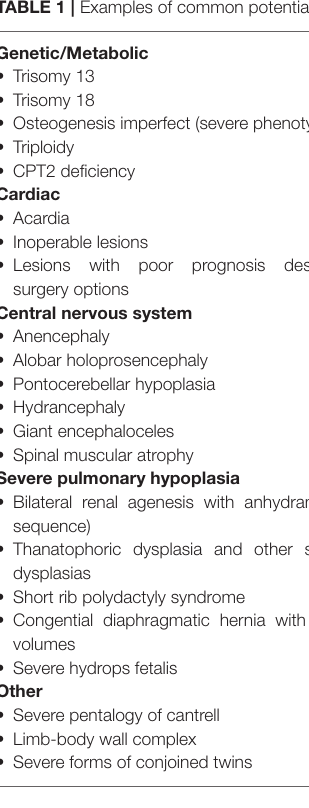
TABLE 1 | Examples of common potentially life-limiting fetal